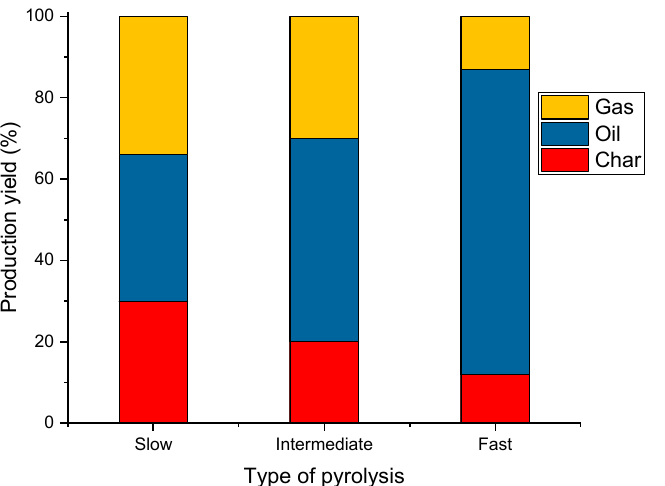
Figure 5. Typical shares of wood biomass pyrolysis products obtained in different types of pyrolysis (data adapted from ref. [103]).